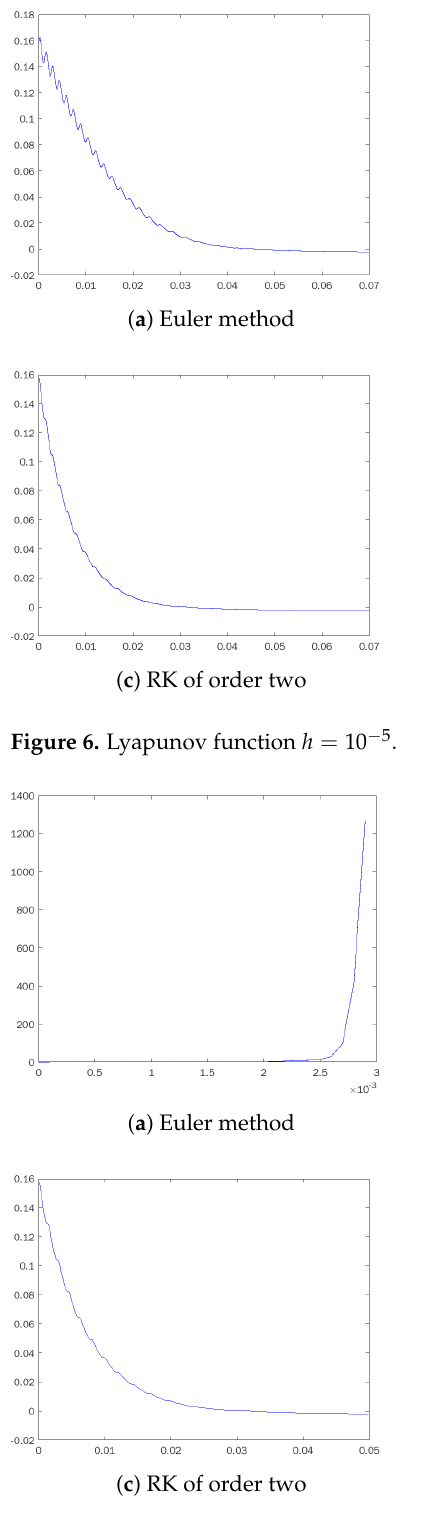
Figure 7. Lyapunov function for h = 10 − 4